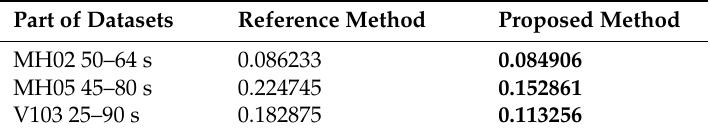
Table 2. Average RPE results at three quivering parts of reference method and our proposed method. The numbers in bold indicate that these terms are better than those of another method. The unit of RPE is meter.